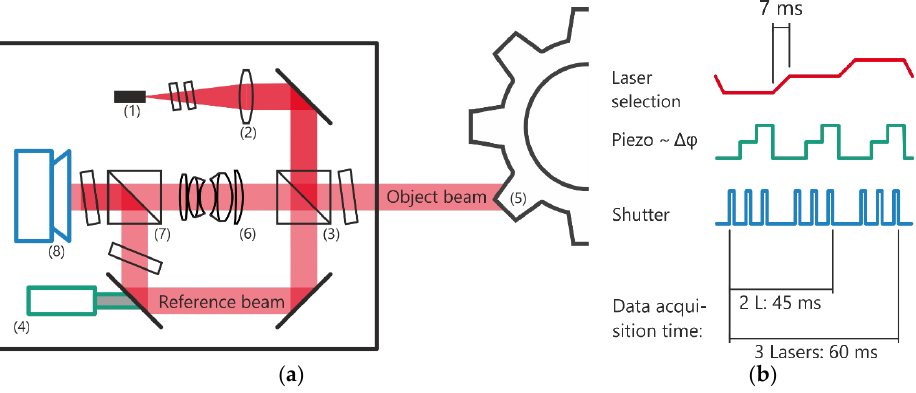
Figure 1. Experimental setup for temporal phase-shifting multiwavelength digital holography: ( a ) sensor internals including laser system (1); lens (2); polarizing beam splitter cubes (3)/(7); piezo (4); camera (8); gear test object (5); and imaging lens (6). The interferometric optical path includes reference and object beams, which are superimposed on the imaging device. Lenses (2) and (6) ensure maximal light yield; ( b ) data acquisition time series using three lasers and three piezo steps for temporal phase shifting. In total, nine camera images are acquired.